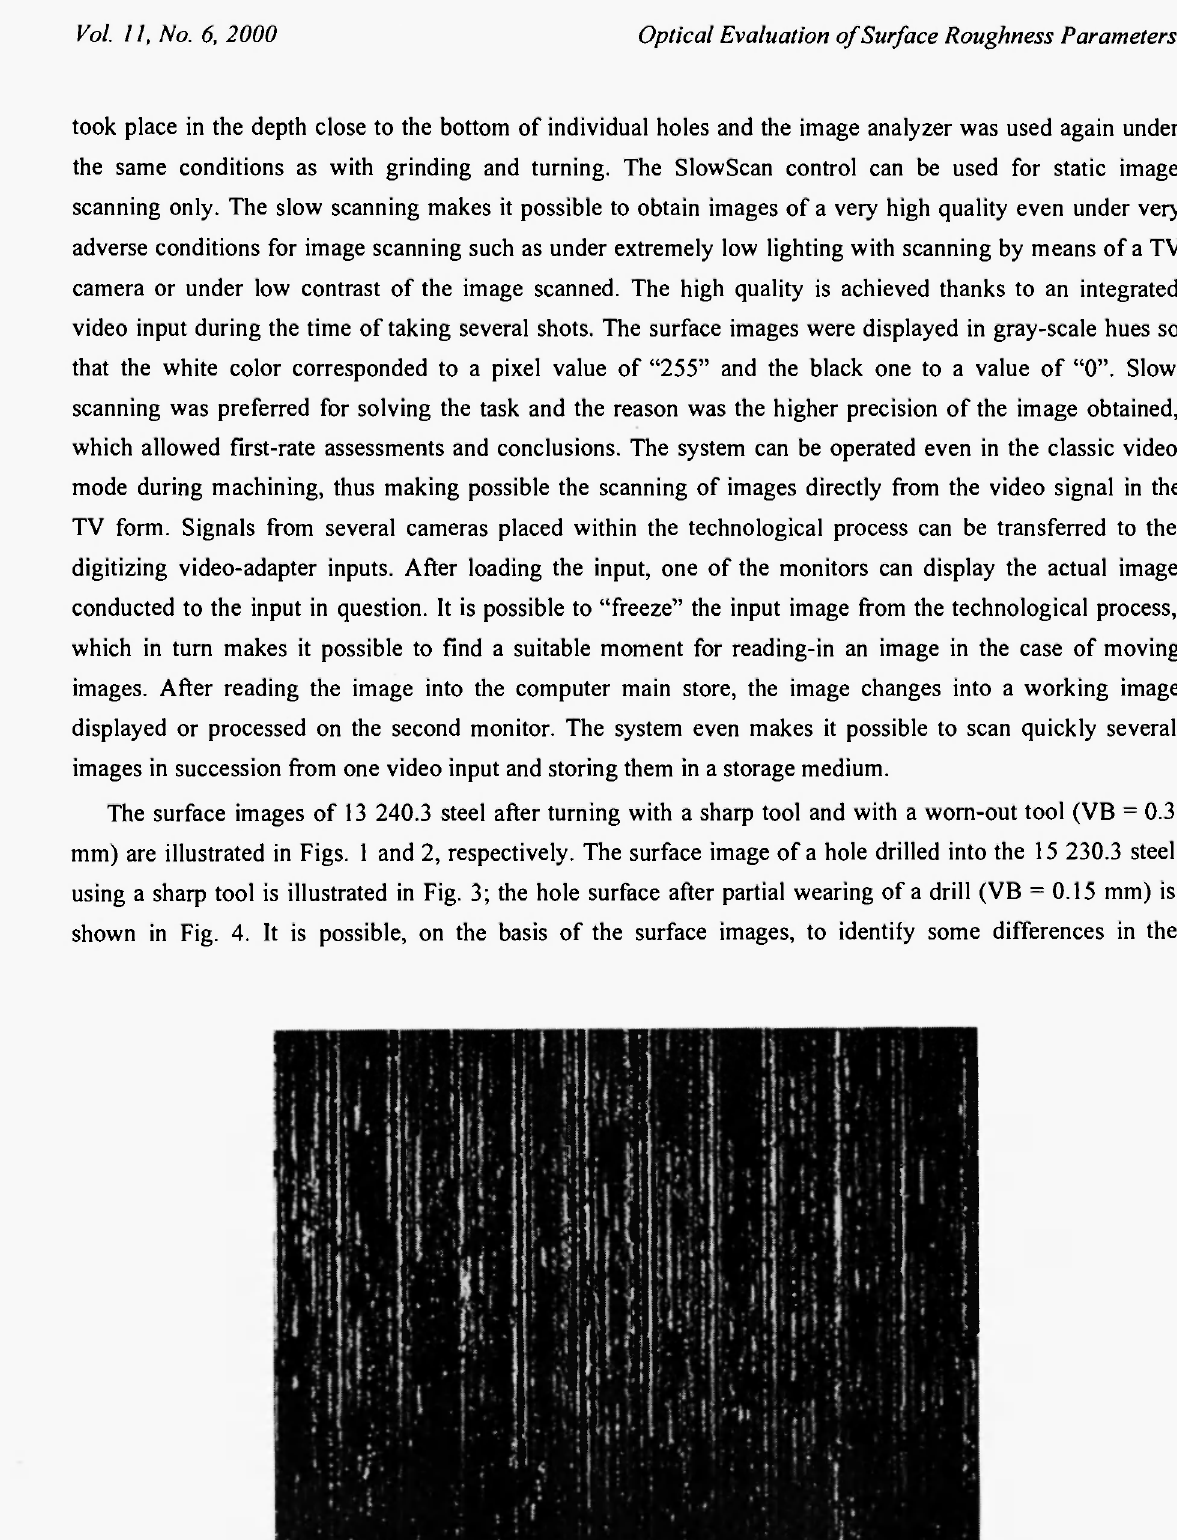
Fig. 1 : Turned steel 13240.3 surface morphology (sharp